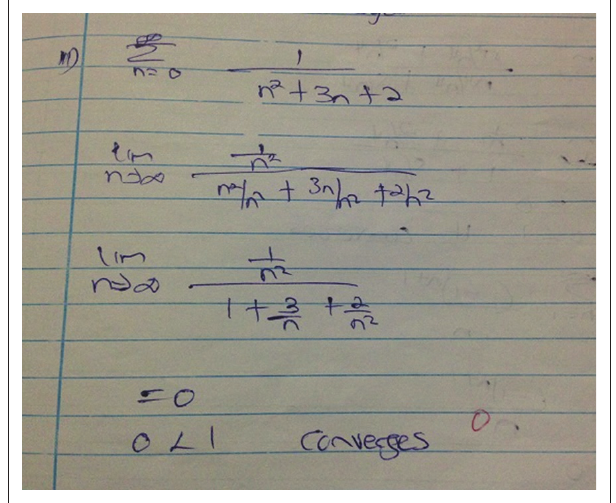
FIG URE 6: Written response of ST20 to task 1b (iii).